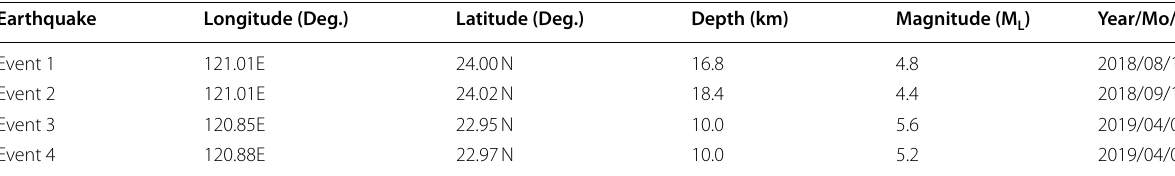
Table 1 Earthquake parameters (Provided by Central Weather Bureau) Earthquake Longitude (Deg.) Latitude